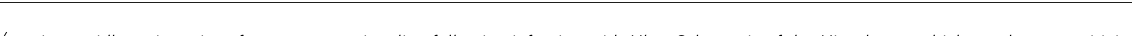
Fig. 1 129.Ra g2 − / − mice rapidly activate interferon-gamma signaling following infection with Hh . a Schematic of the Hiccs locus, which regulates sensitivity to Hh -driven innate colitis. b Colitis phenotypes after Hh infection of B6. Rag1 − / − , 129. Rag2 − / − , or congenic 129. Rag2 − / − mice bearing a Hiccs locus that matches the B6 genotype (129. Hiccs B6 . Rag2 − / − ). c – e Transcriptomic pro fi ling of whole-colon tissue from 129. Rag2 − / − and 129. Hiccs B6 . Rag2 − / − mice 2 days after oral Hh infection ( n = 4 per group). c Tornado plot displaying log 2 fold differences in 129. Rag2 − / − versus 129. Hiccs B6 . Rag2 − / − mice. IFN- γ - regulated genes are indicated in red. d Gene set enrichment analysis (GSEA), showing enrichment of the “ interferon-gamma response ” hallmark gene set in colon tissue from 129. Rag2 − / − mice. e The top 100 differentially expressed genes (high in 129. Rag2 − / − mice) were analyzed for gene ontology (GO) term enrichment using ClueGO. The most highly enriched GO terms are shown, with lead terms and associated p -values indicated. f RT-qPCR analysis of whole- colon gene expression after Hh infection. Data analyzed by two-way ANOVA ( n = 4 per group per time point). P -values indicate day 2 comparisons corrected with Sidak ’ s multiple comparisons tests (DF = 17 for each comparison). g IFN- γ secretion by colon explant tissue cultured overnight ex vivo at steady state or following Hh infection. ND no IFN- γ detected in culture supernatant. Data ( Hh day 2) analyzed by Mann – Whitney test ( n = 4 per group/ timepoint). Data in c – g are from one